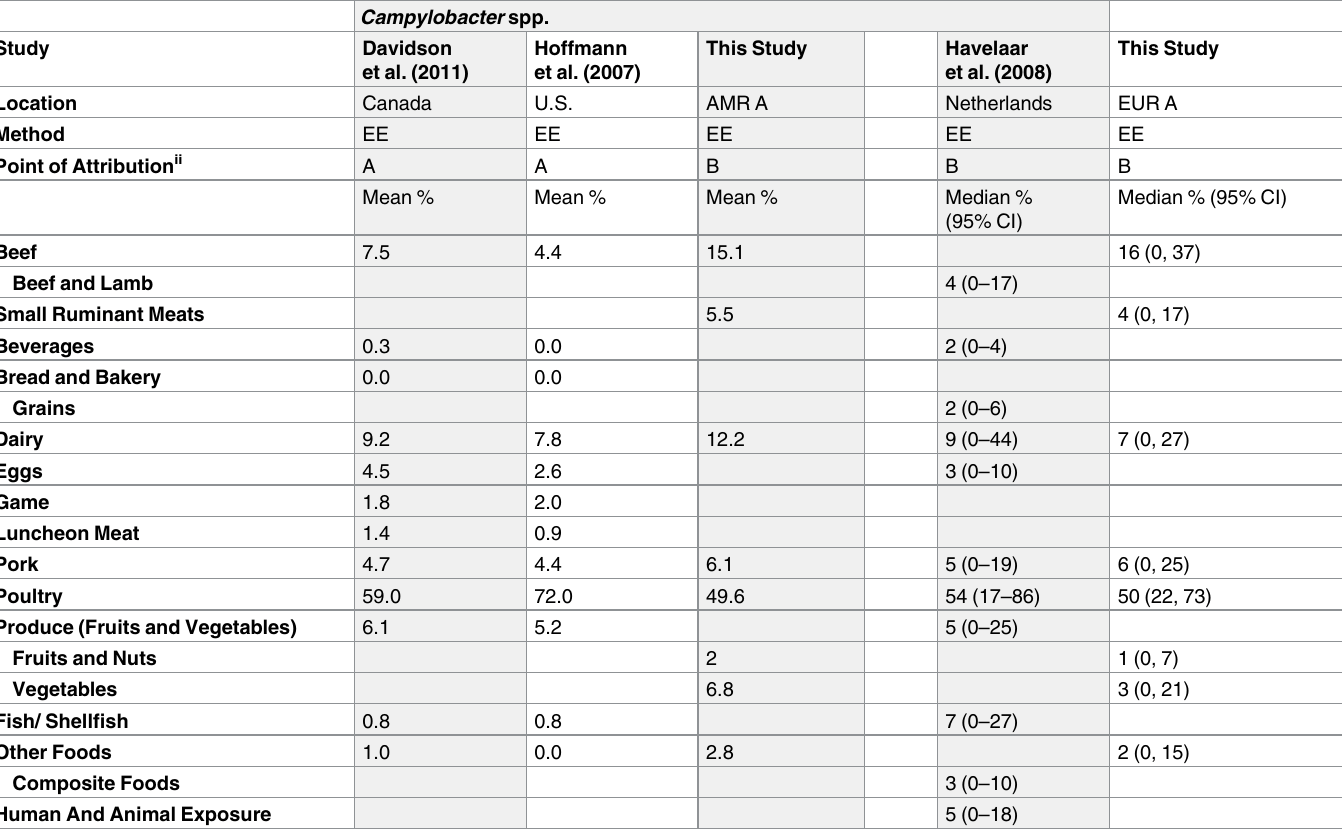
Table 3. Campylobacter spp. Percent of foodborneillnessesattributed to specifiedfood exposures from prior national studies and this study. Campylobacter